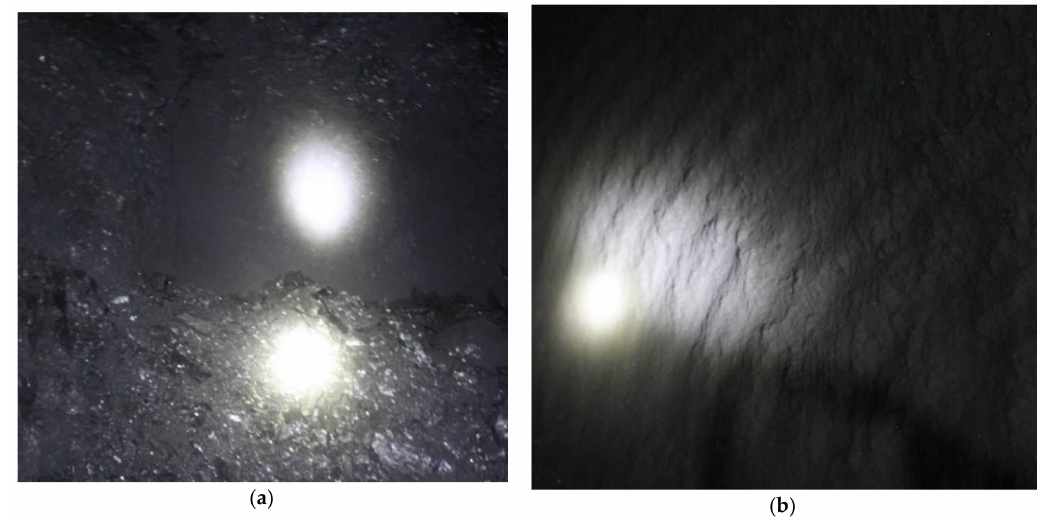
Figure 9. Coalfaces before ( a ) and after ( b ) using water